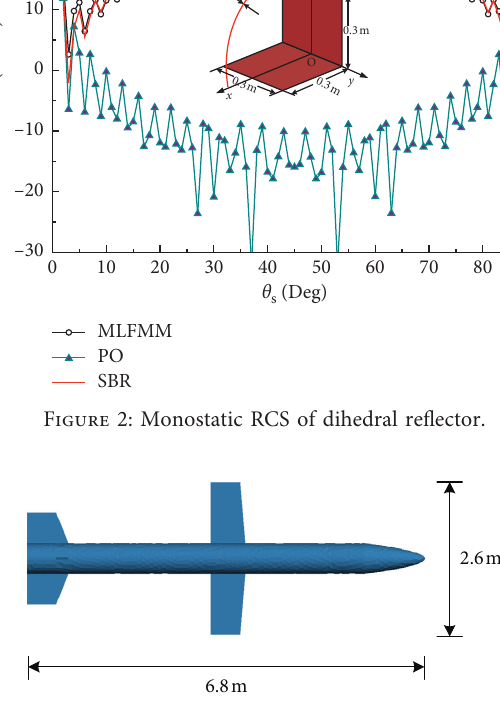
Figure 3: Geometry of the missile model.